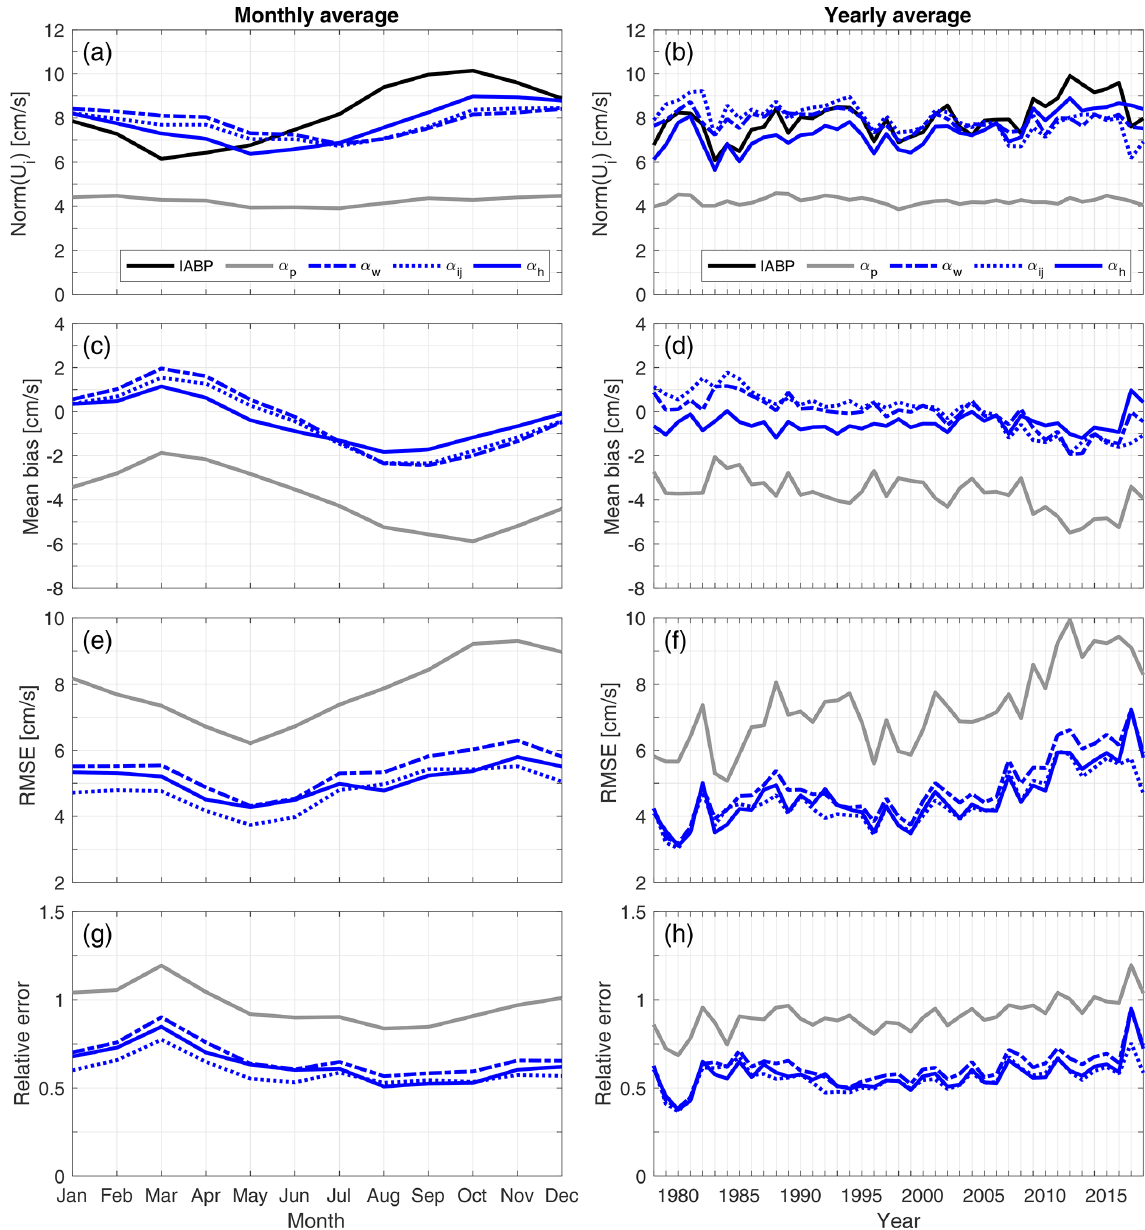
Figure 5. Comparison between co-located IABP buoy drifts and the Polar Pathfinder free-drift input ( α p , gray), free drift based on a single wind–ice–ocean transfer coefficient ( α w , dashed blue), free drift based on static maps of the transfer coefficient and turning angles ( α ij , dotted blue), and the free drift including a dependence on sea ice thickness ( α h , blue). All three α w , α ij , and α h parameterizations take into account ocean current estimates. Plots show the seasonal cycle of monthly averaged: (a) drift speed, (c) mean bias error, (e) root-mean-square error, and (g) relative error; and the 1979–2019 yearly averaged time series of (b) drift speed, (d) mean bias error, (g) root-mean-square error, and (h) relative error. The relative error is defined as the root-mean-square error divided by the mean buoy drift